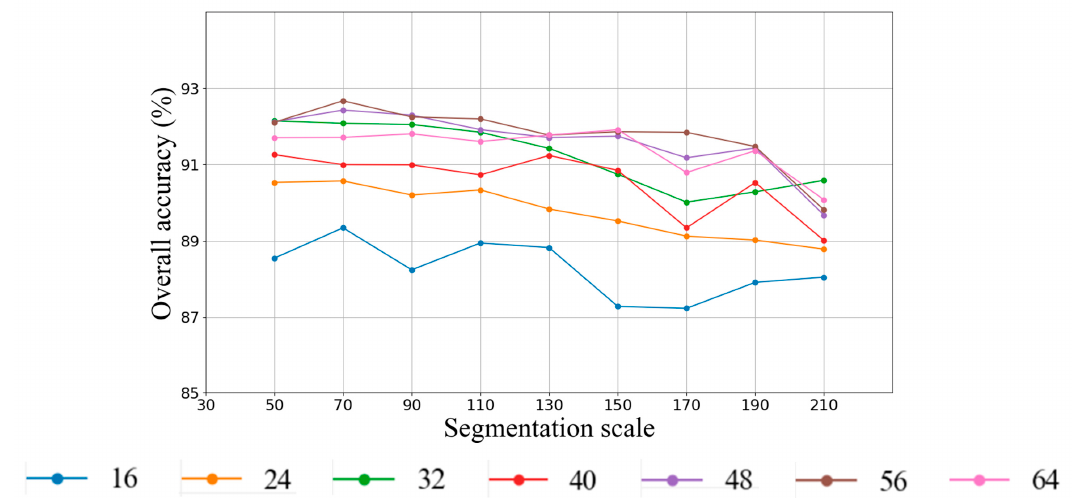
Figure 12. The variation of overall accuracies over segmentation scales (the horizontal axis refers to segmentation scale, the vertical axis refers to accuracies, and different curves represent different patch sizes).